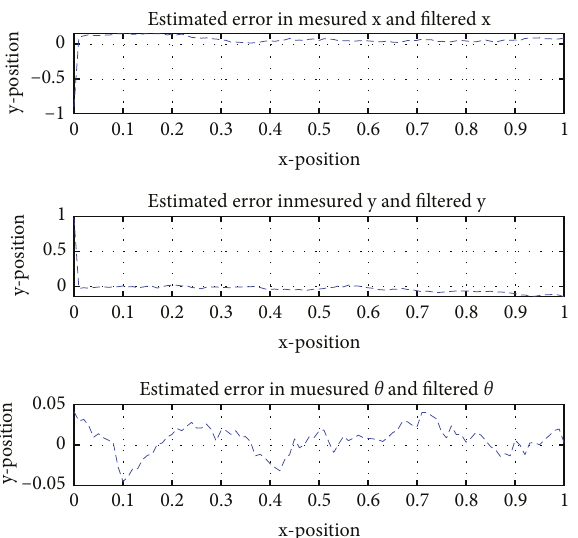
Figure 18: The induced filtering error with the PF (two landmarks and Gaussian noise).